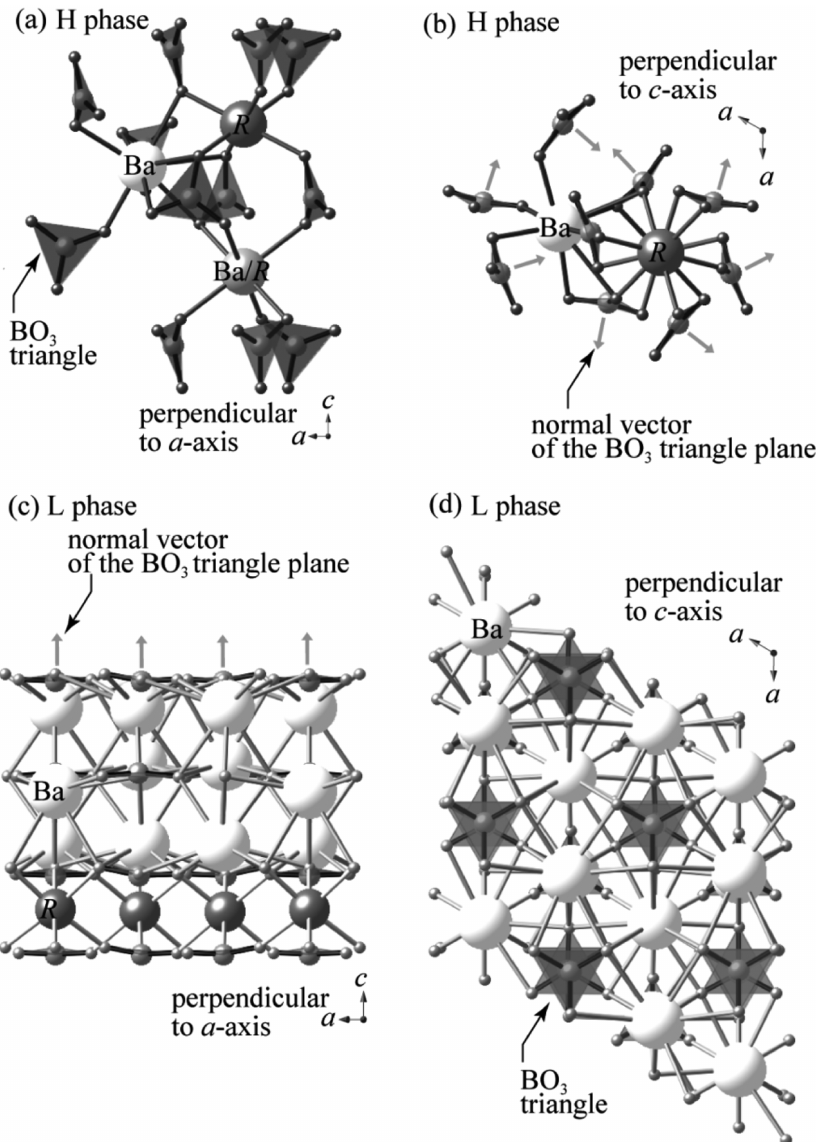
Figure 6: Crystal structure of Ba 3 R B 3 O 9 focused on the direction of the BO 3 tri- angles illustrated in black